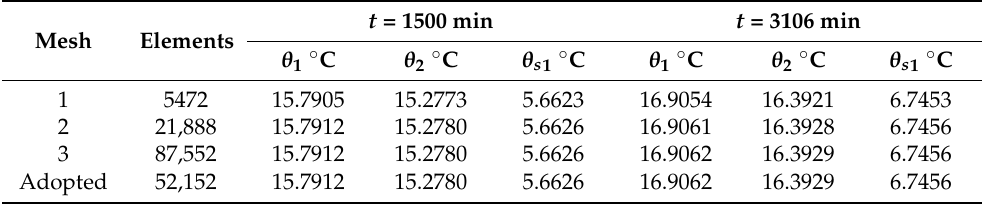
Table 3. Preliminary estimate of k s : values of θ 1 , θ 2 , and θ s 1 at selected instants of time, obtained by different meshes, with k g = 0.862 W/(mK), ( ρ c ) g = 3.8 MJ/(m 3 K), α s = 1.00 × 10 − 6 m 2 /s, and k s = 3.18